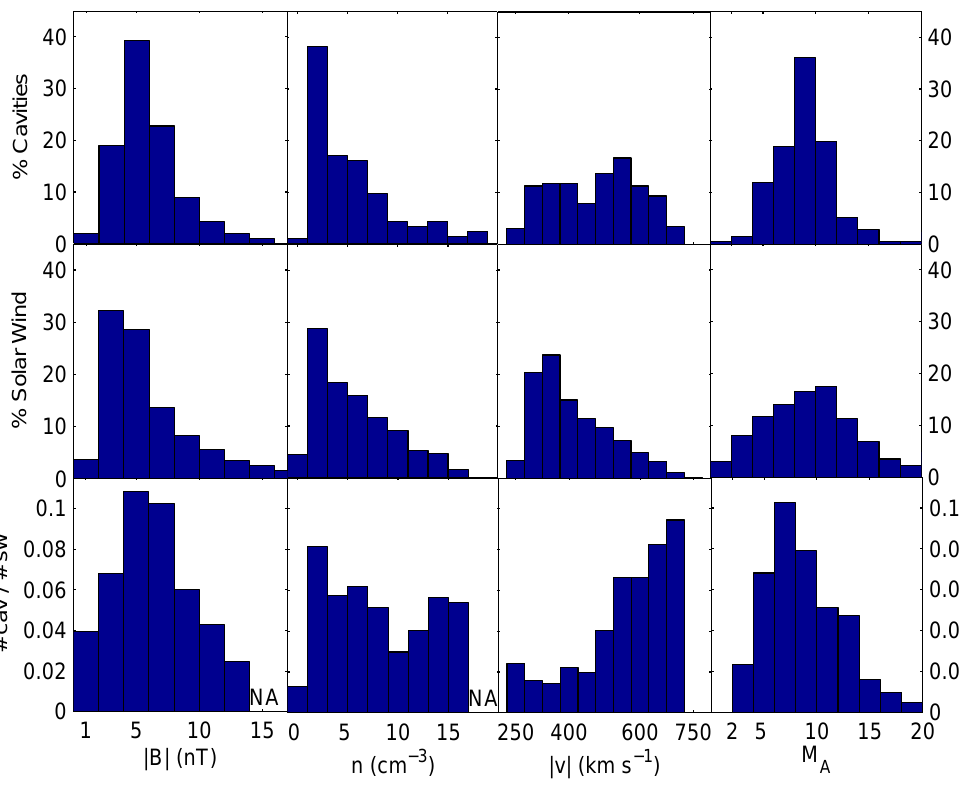
Fig. 8. Distributions of (in columns left to right): magnetic field magnitude, thermal ion density, bulk flow speed, and Alfv´en Mach number, for (rows top to bottom): the foreshock cavities surveyed in this paper, hourly averages of solar wind during the survey period, occurrence patterns for the cavities normalised by those for the solar wind parameters. Hourly averaging for solar wind parameters suppresses the tails of their distributions in comparison to the distributions of the ∼ two-minute averages taken of cavity surroundings. This can lead to very high bin occupancy in the tails of the distributions when taking ratios. Affected bins have been suppressed to better illustrate the main results. Deleted bins are marked NA in the bottom row.